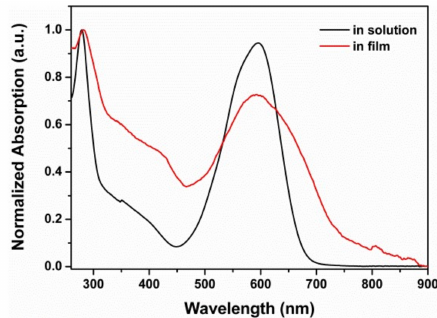
Figure 1. UV-vis absorption spectra of 4BAI-SFX in CHCl 3 solution and in